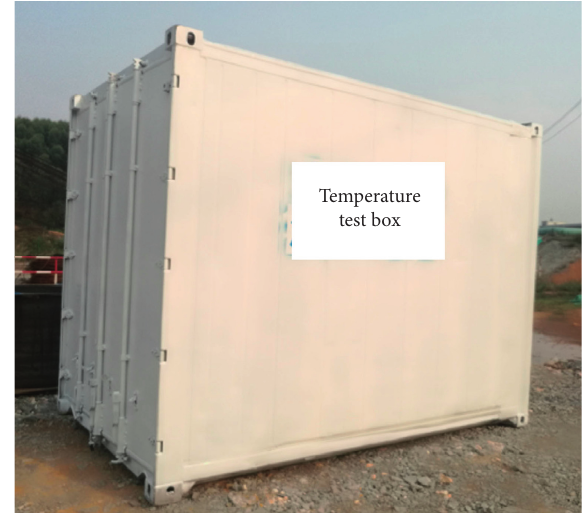
Figure 4: Temperature test